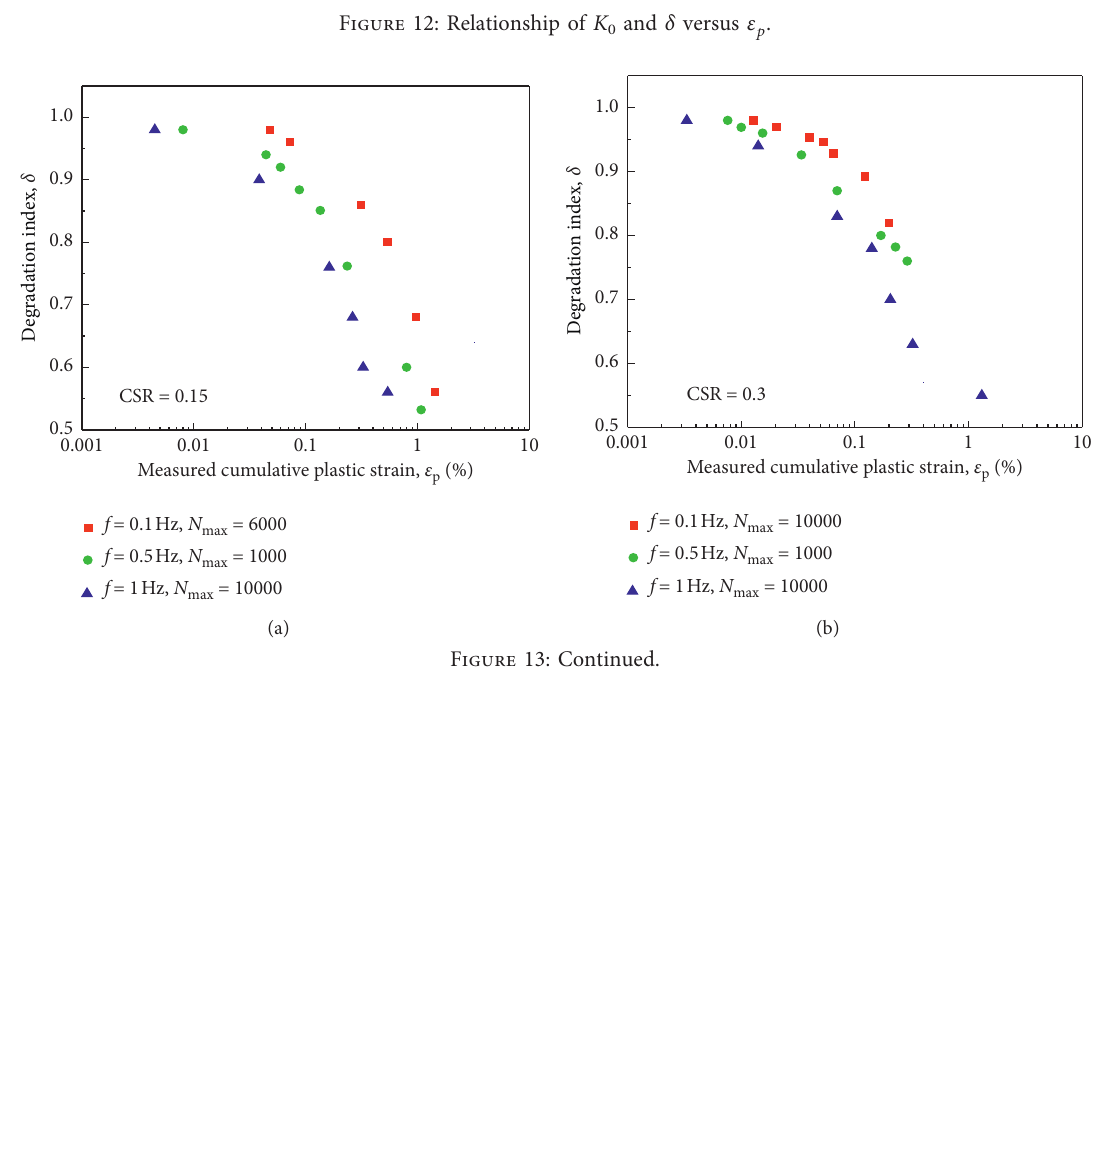
0 and δ versus ε p .